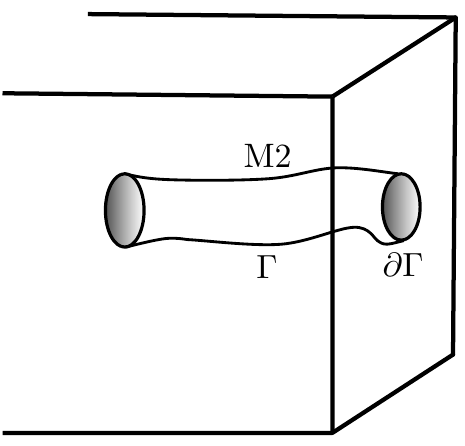
Figure 2 . State insertion of a membrane wrapping a three-cycle (cid:0) with boundary @ (cid:0).